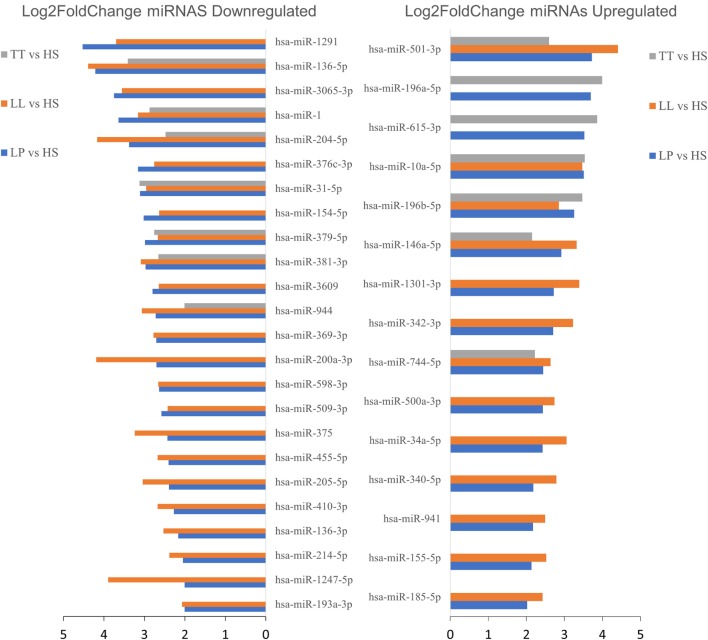
Upregulated or downregulated microRNAs (miRNAs) in at least two comparisons [tuberculoid (TT) vs. healthy subjects (HS), lepromatous (LL) vs. HS, or leprosy patients (LP) vs. HS] on skin biopsies samples. Among the 67 differentially expressed miRNAs (|log2 fold change| > 2 and adjusted p-value < 0.05), here we highlight 39 miRNAs differentially expressed between HS versus LP and HS versus LL or TT patients, each indicated by blue, orange, and gray bars, respectively. The barplot represents each miRNA (y-axis) absolute log2 fold change (x-axis) for each comparison and separated in up- and downregulated miRNA regarding HS.